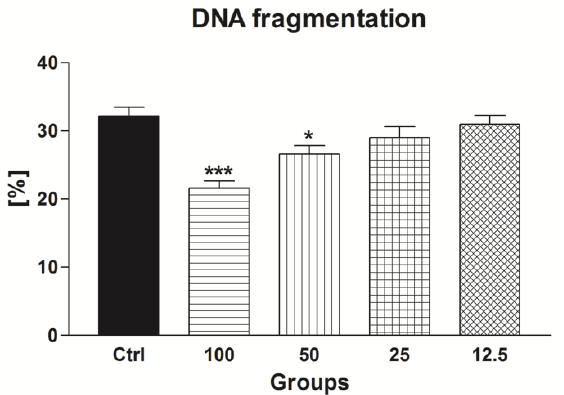
Figure 9. The e ff ect of epicatechin (EPI; µ mol / L) on the sperm DNA fragmentation by frozen-thawed Figure 9. The effect of epicatechin (EPI; μ mol/L) on the sperm DNA fragmentation by frozen-thawed bovine spermatozoa. * p < 0.05; ** p < 0.01; *** p < 0.001. bovine spermatozoa. * p < 0.05; ** p < 0.01; *** p < 0.001.